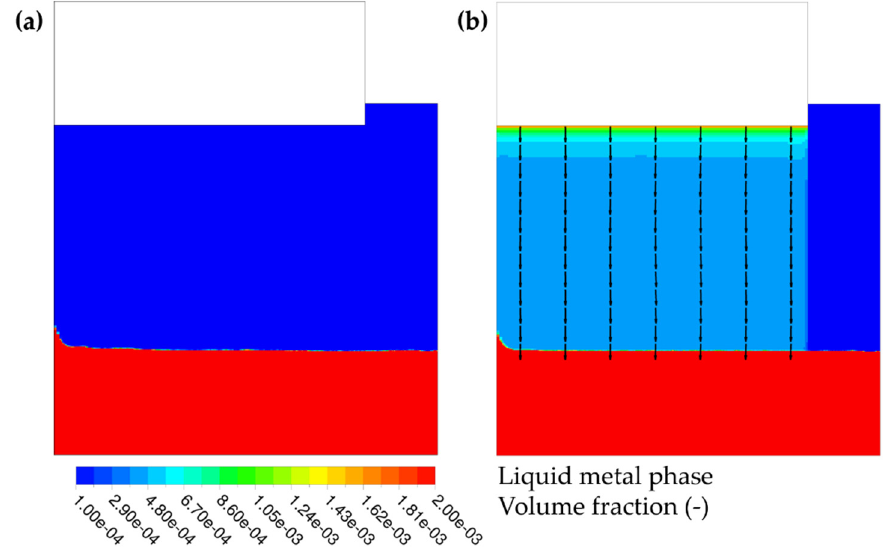
Figure 5. Liquid metal volume fraction fields (time-averaged) without drops ( a ) and considering the drops falling through the slag ( b ). Normalized velocity vectors of the liquid metal drops are plotted in black on (b).